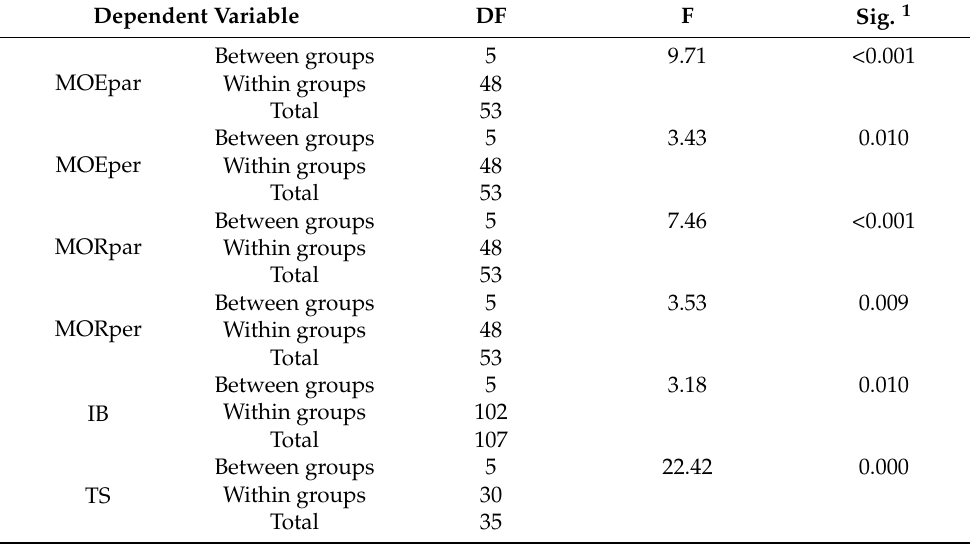
Table 4. ANOVA procedure summary for the physical and mechanical